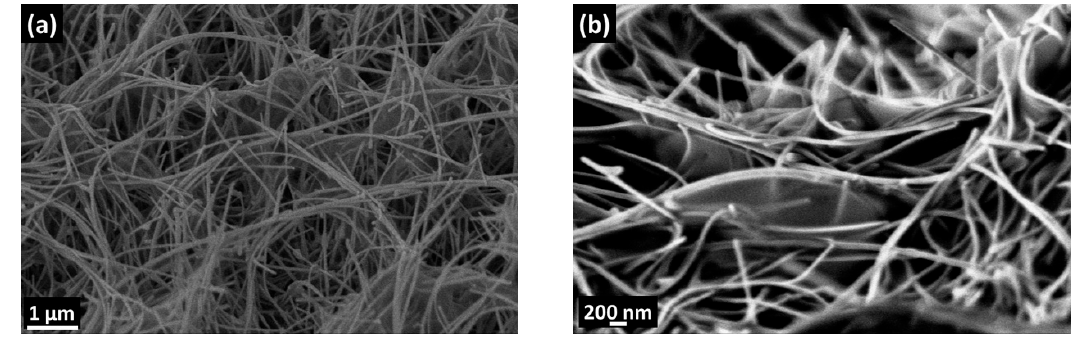
Figure 4. SEM images of chitosan-deposited SnO 2 nanowires ( a ) 45° tilted and ( b ) 75° tilted surfaces.